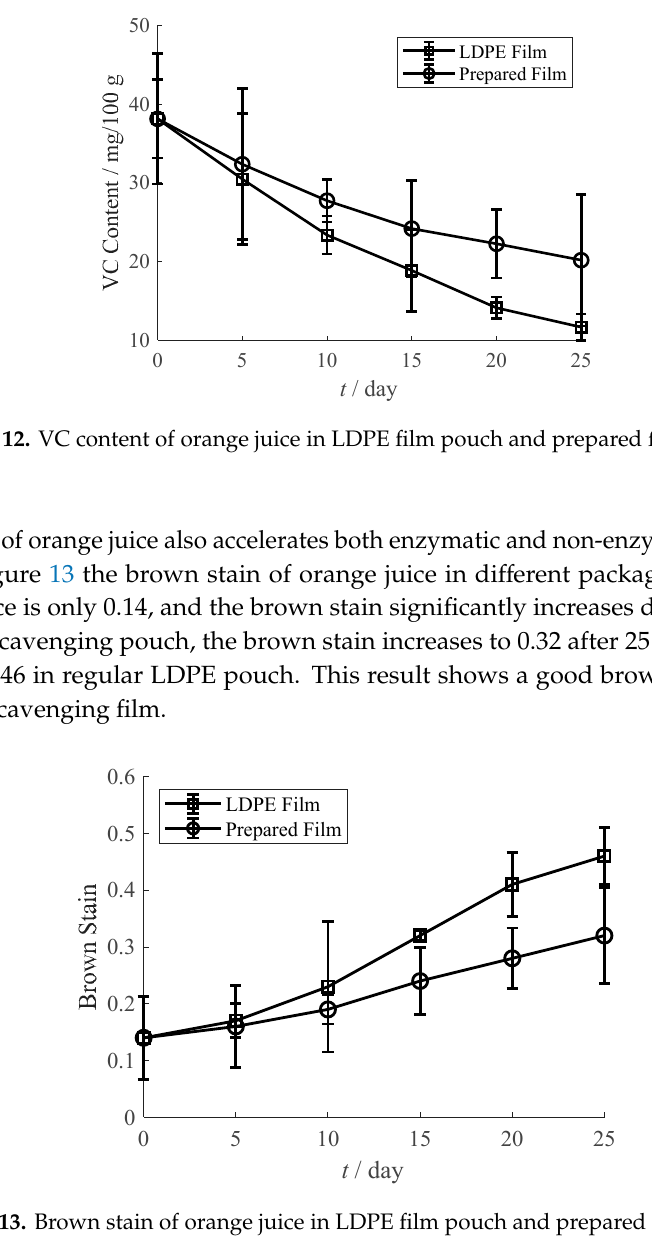
Figure 11. Heat sealing strength of the prepared films under different oxygen scavenger content.